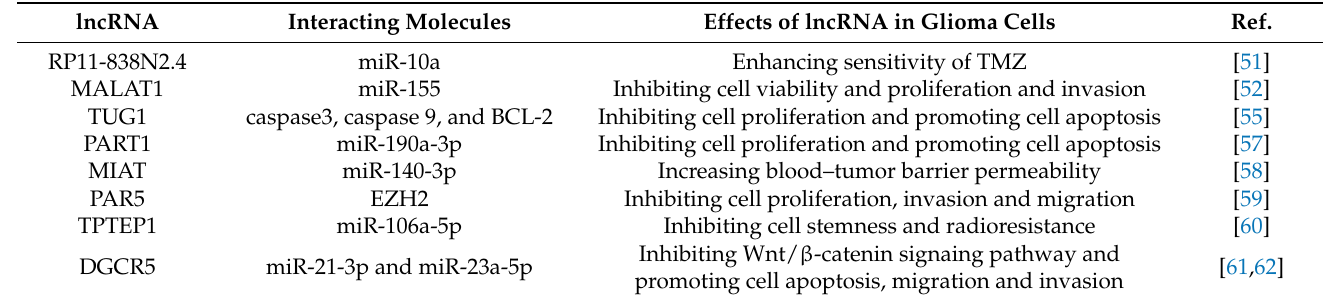
Table 2. Tumor-suppressive lncRNAs downregulated in glioma. Effects of lncRNA in Glioma